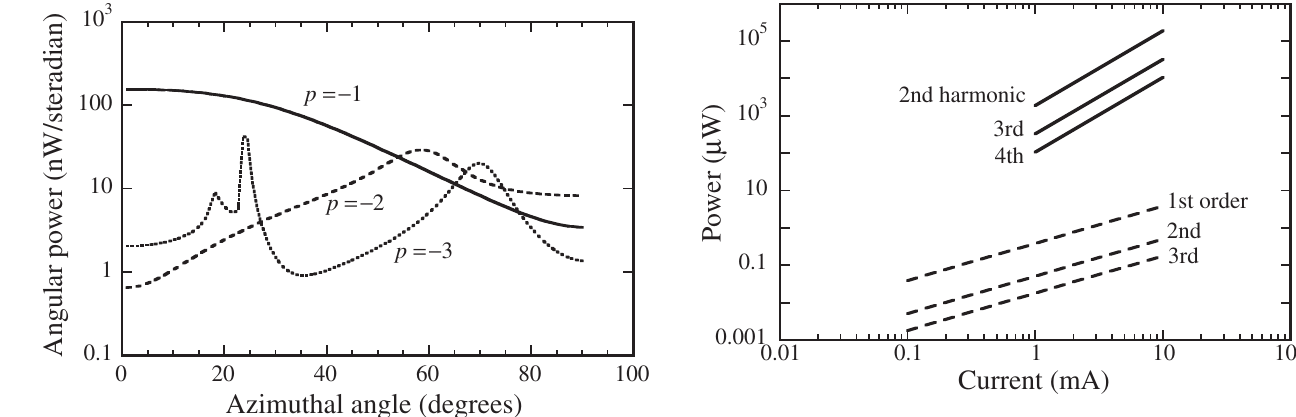
FIG. 4. Angular power of incoherent SP radiation on the first few orders versus azimuthal angle (cid:5) at (cid:3) (cid:1) 89 (cid:13) .